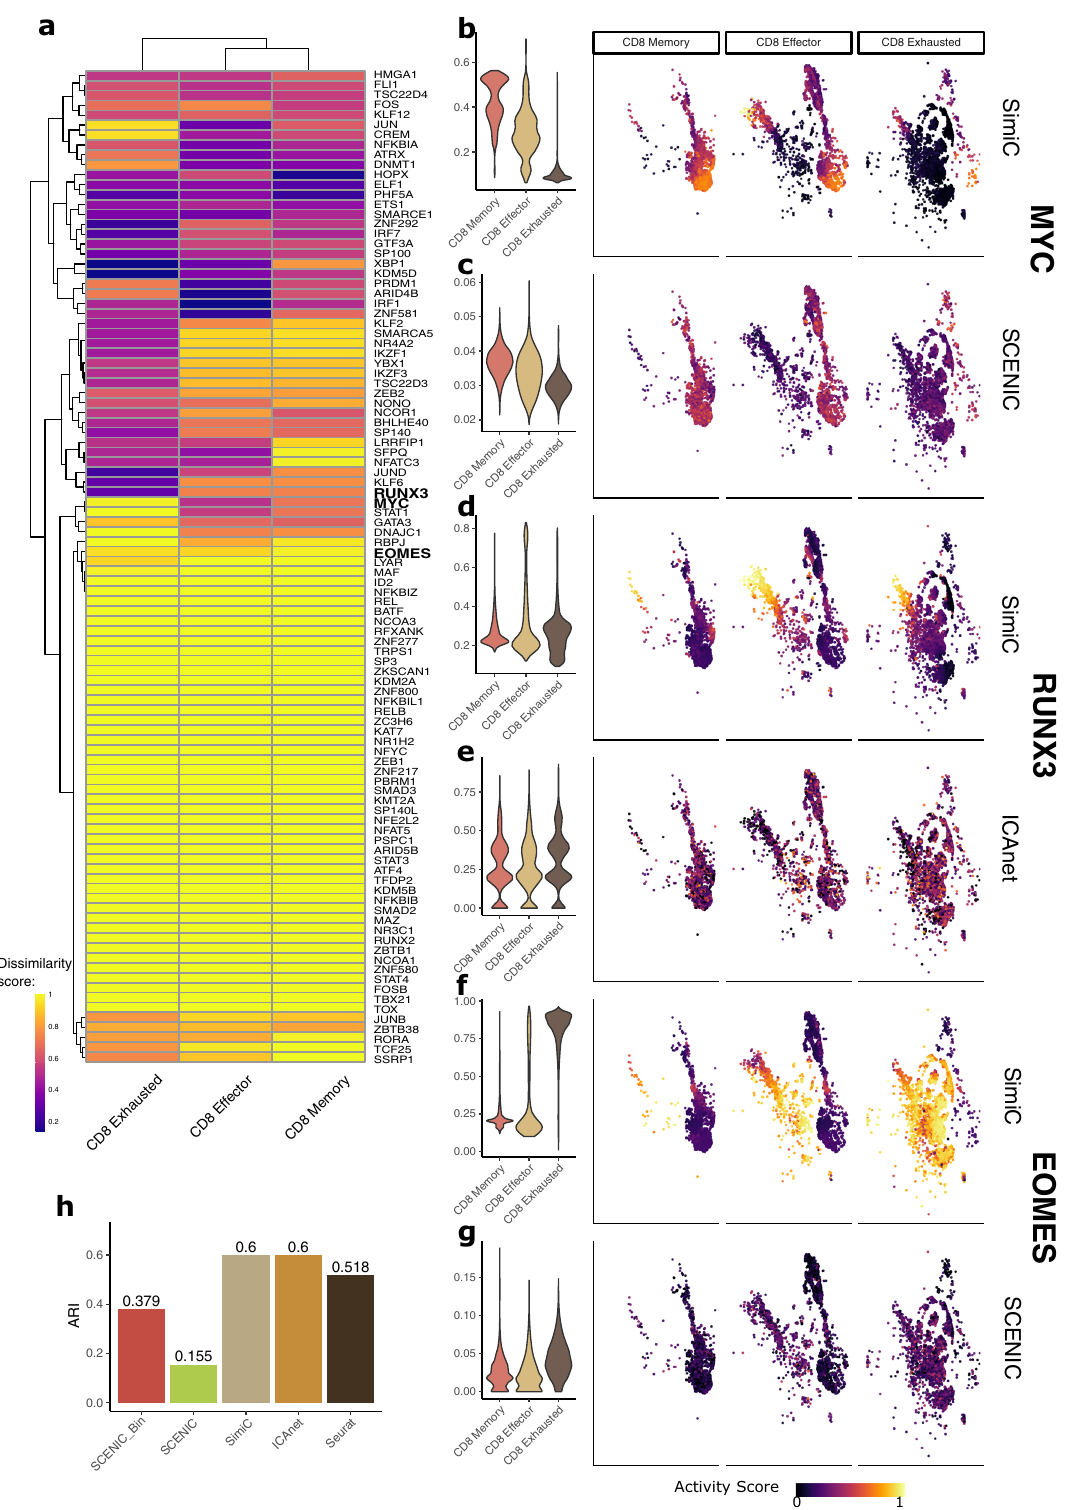
Fig. 5 SimiC ’ s proposed scores capture cell-state speci fi c regulatory dynamics on the CD8 + CAR T cell dataset 52 . a Heatmap depicting the regulatory dissimilarity between the two cell phenotypes (IP and D12) for different regulons for CD8 + exhausted, CD8 + effector, and CD8 + memory cells. Violin plots of the activity scores for the different cell states, as well as the tSNE plots showing the CAR T cells of different cell states colored by their activity score for the MYC regulon as calculated by SimiC ( b ) and SCENIC ( c ); for the RUNX3 regulon as calculated by SimiC ( d ) and ICANet ( e ); and for the EOMES regulon as calculated by SimiC ( f ) and SCENIC ( g ). h Cell state clustering performance as measured by the ARI score. For SCENIC we consider the binarized and non-binarized scores. A larger ARI indicates a better clustering performance. SINCERITIES was left out of the analysis as it needs at least four phenotypes to